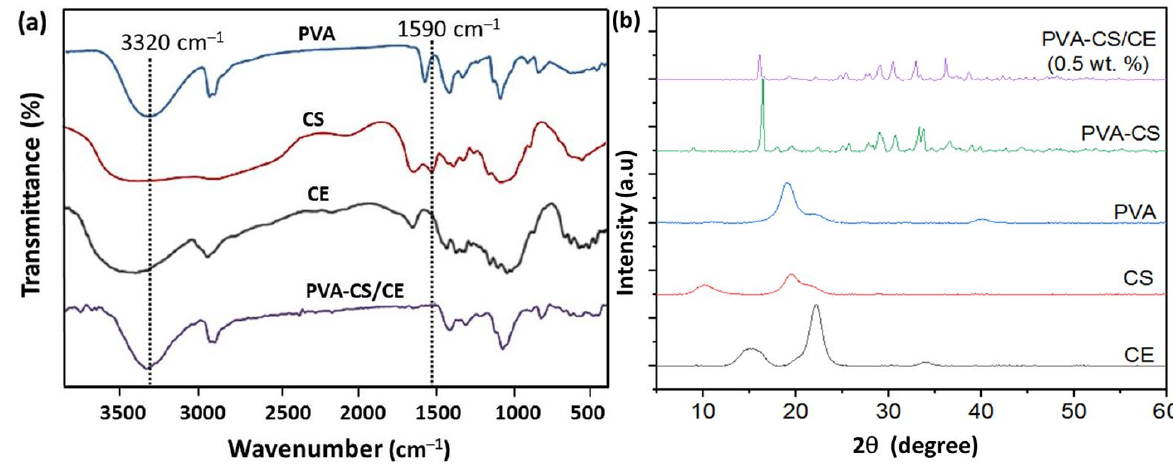
Figure 3. ( a ) FTIR spectra and ( b ) X-ray diffraction patterns of PVA, CS, CE, PVA-CS control hydrogel, and PVA-CS/CE composite hydrogel.